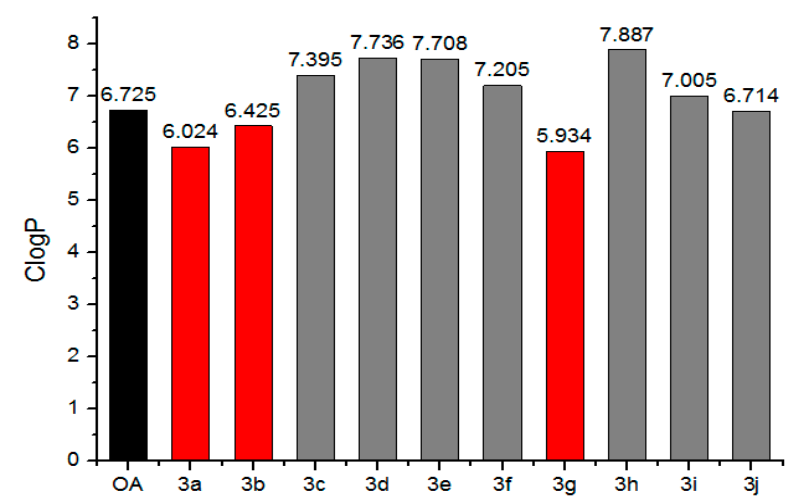
Figure 1. The ClogP values online simulation results of OA-amino acid derivatives.